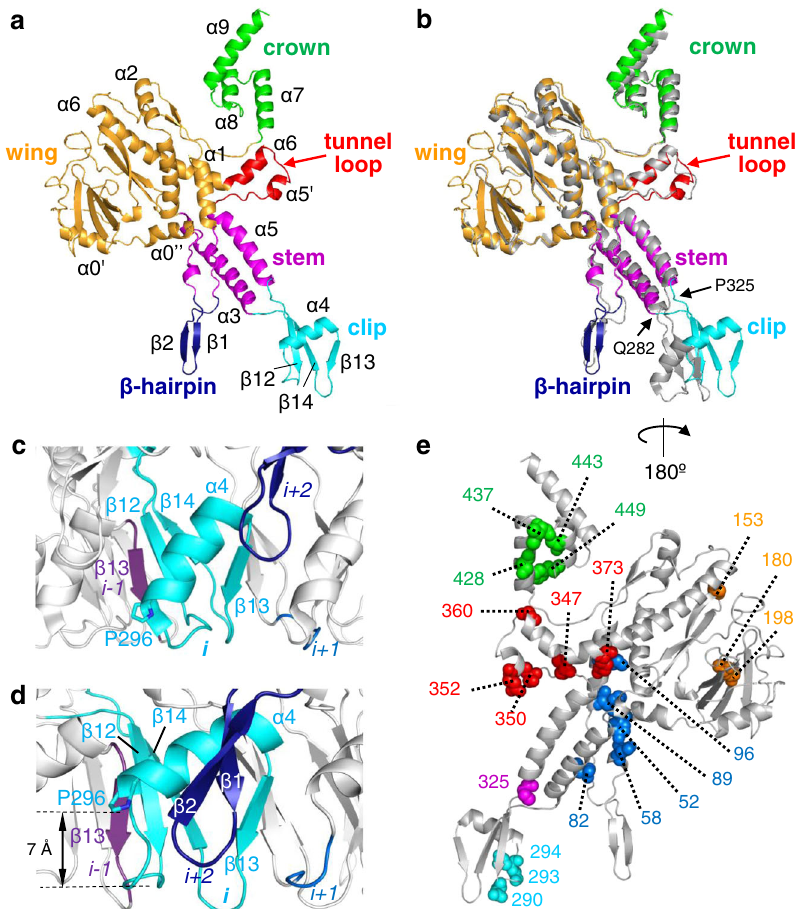
Fig. 2 | Comparison of SPP1 portal protein gp6 structures and localization of mutations impairing viral DNA packaging. a Secondary structural elements of the gp6 subunit in the SPP1 connector. Domains are colour coded: the crown domain (residues 421 – 470) is in green, the wing domain (residues 28 – 54, 88 – 255 and369 – 420)inorange,thetunnelloopwiththetiltedregionofhelix α 6(residues 347 – 368)inred,thestemdomain(residues55 – 62,81 – 87,256 – 280and327 – 346)in magenta,the gp6 β -hairpin (residues 63 – 80) in blue and the clipdomain (residues 281 – 326) in cyan. b Superposition of the gp6 subunit from the connector (12-mer) and the subunit of thegp6assembly-naïve 13-mer (shown in grey;PDB2JES). c